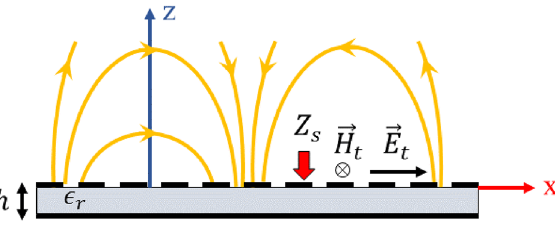
Figure 1. Surface impedance boundary condition implemented on a grounded dielectric slab. The propagation direction is assumed to be along the